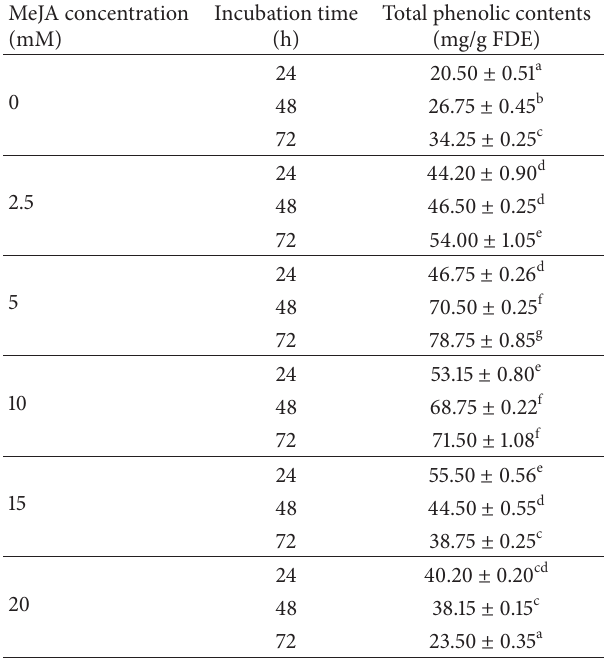
Table 1: Effect of concentration and timing of methyl jasmonate (MeJA) treatments on phenolic content in cotton